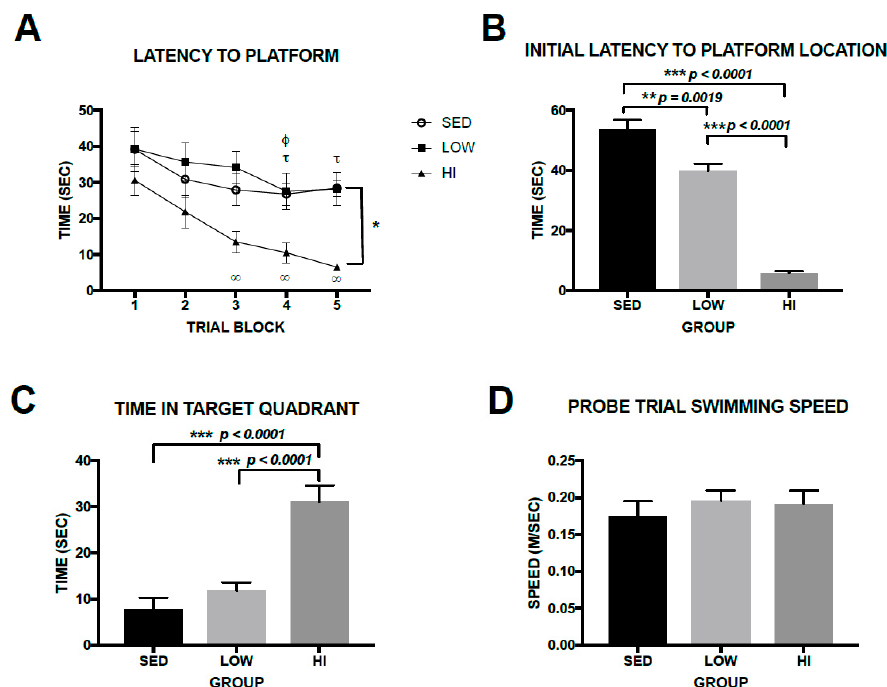
Figure 4. Exercise training intensity plays a role in Morris Water Maze performance in Tg2576 mice. Panel A shows latency to the platform during the place trials. Relative to day 1, latency was significantly faster in HI mice on day 3 ( ∞ p = 0.0003), day 4 ( ∞ p < 0.0001), and day 5 ( ∞ p < 0.0001). Relative to day 1, the LOW mice were significantly faster to the platform on day 4 ( τ p = 0.0005) and day 5 ( τ p = 0.0012) and the SED group was significantly faster to the platform on day 4 ( ϕ p = 0.04). The HI group was significantly faster to the platform than the LOW group on day 5 (* p = 0.05). Panel B shows the initial latency to the platform location during the probe trial. Panel C depicts time in target quadrant during the probe trial. Panel D shows that swimming speed during the probe trial. Values represent the mean ± s.e.m.